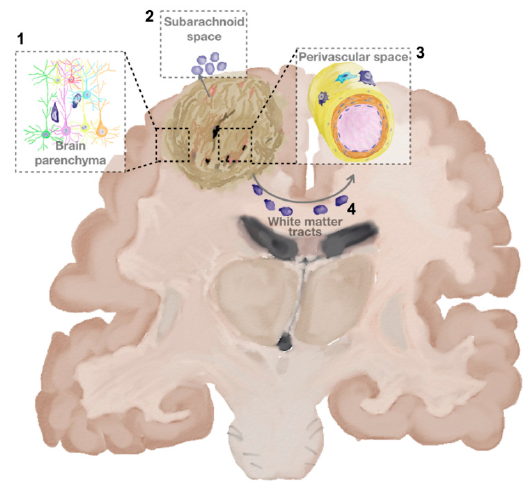
Figure 1. Preferential migration routes of glioblastoma cells. Tumour cells (dark blue) tend to invade the brain along pre-existing brain structures, such as interstitial spaces of the brain parenchyma (1); the subarachnoid space (2); the perivascular space (3) and white matter traits (4).